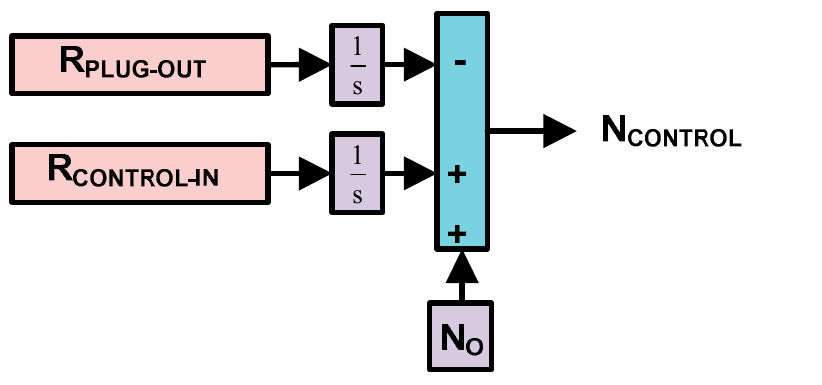
Figure 3. Number of controllable EVs.